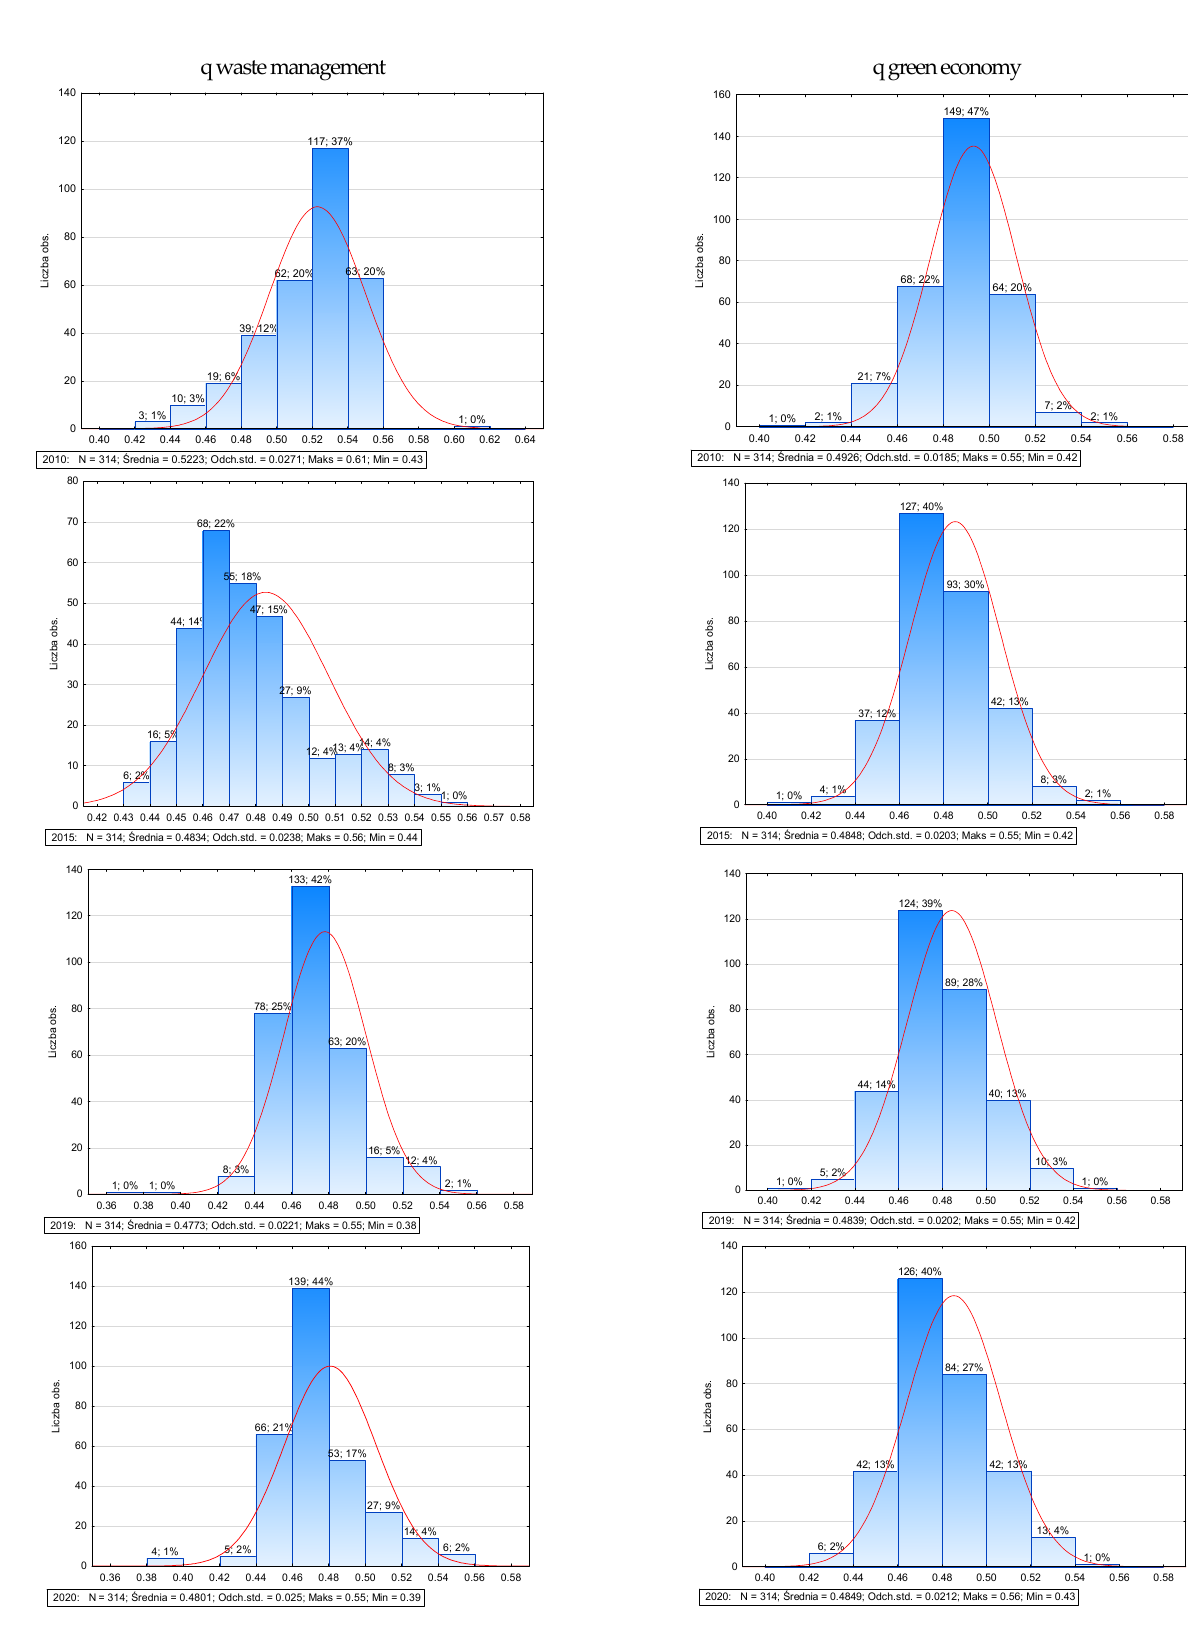
0.26 Source: own elaboration based on BDL GUS data. Figure 4 shows the number of observations and the distribution pattern of the sum- mary measure of waste management and green economy of neighborhoods in the years 2010, 2015, 2019, and 2020. In the analyzed measures of waste management and the green